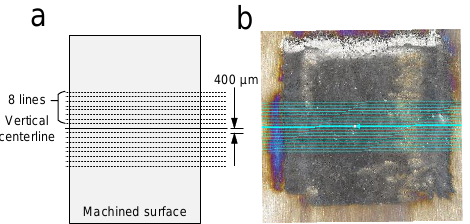
Figure 5. ( a ) Horizontal contour measuring method. The solid line at the center represents the center of the selected vertical direction, and the dashed lines on the upper and lower sides represent other measurements taken by averaging. ( b ) Physical image of measuring.